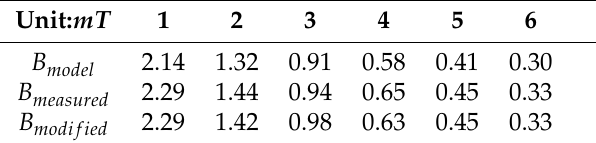
Table 1. Multi-point calibration relating to the mathematical model through a given coil.